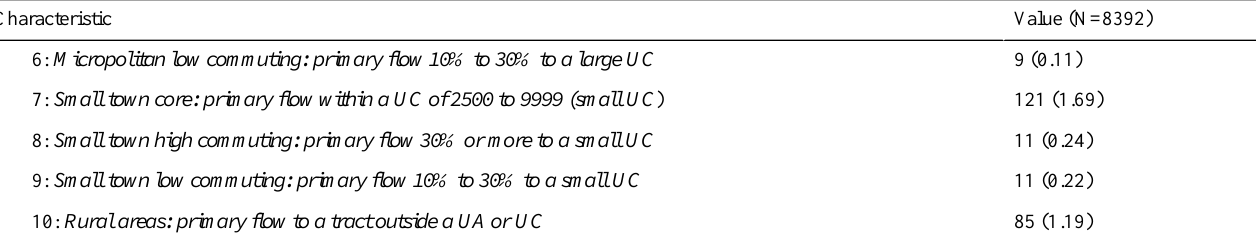
Table 2. Baseline psychological outcomes, physical activity, and perceived effects of COVID-19. Psychological